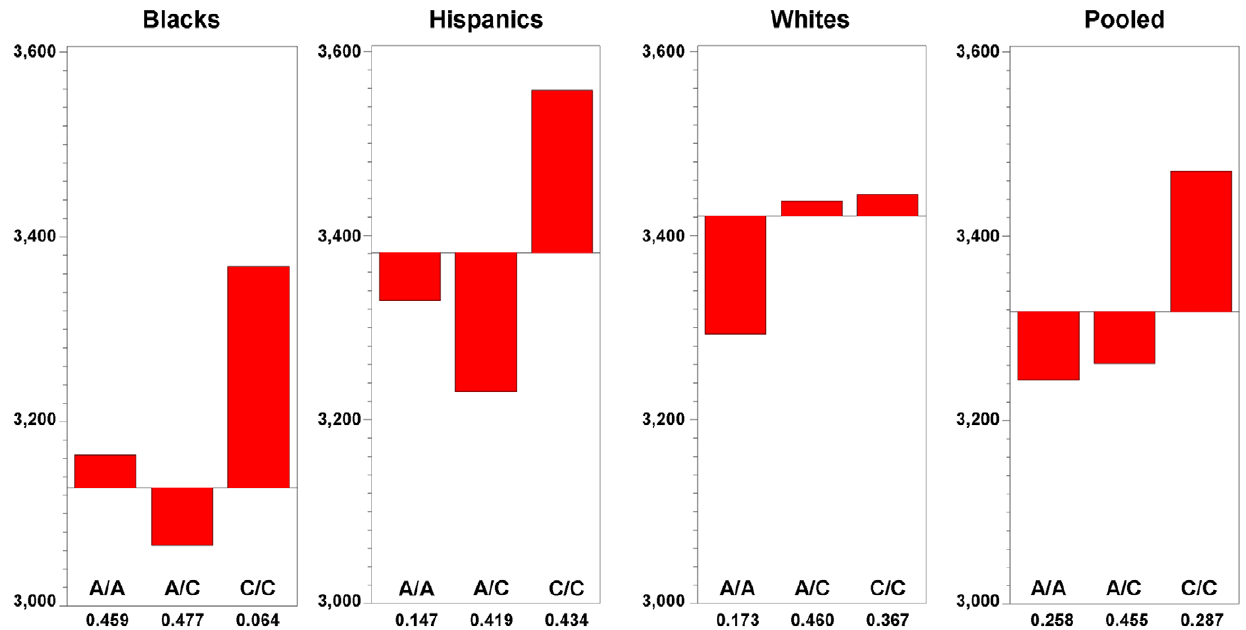
Figure 1. Birth weight means in grams for CRH-BP SNP rs1053989 genotypes. Birth weights adjusted by length of gestation, child sex, maternal BMI, parity,